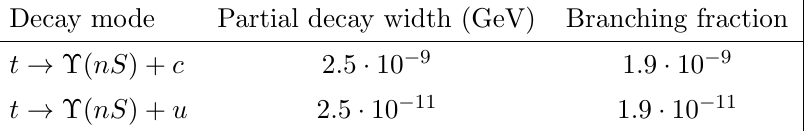
Table 4 . Partial widths and branching fractions of top-quark two-body decays into an (cid:7) meson plus a jet computed here. The branching fractions consider a total top-quark width of (cid:0) t = 1 : 35 GeV [1]. (Theoretical uncertainties, of the order of 10%, not